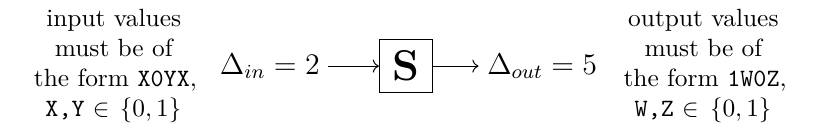
Figure 2: An illustration of how the input and output values (in binary representation) are restricted through a nonlinear layer, using SKINNY-64 4-bit Sbox as an